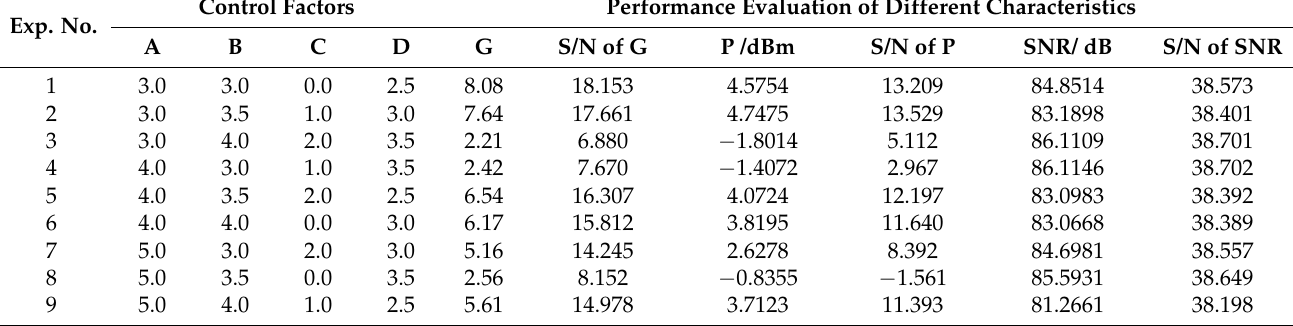
Table 3. Taguchi experiments and the performance